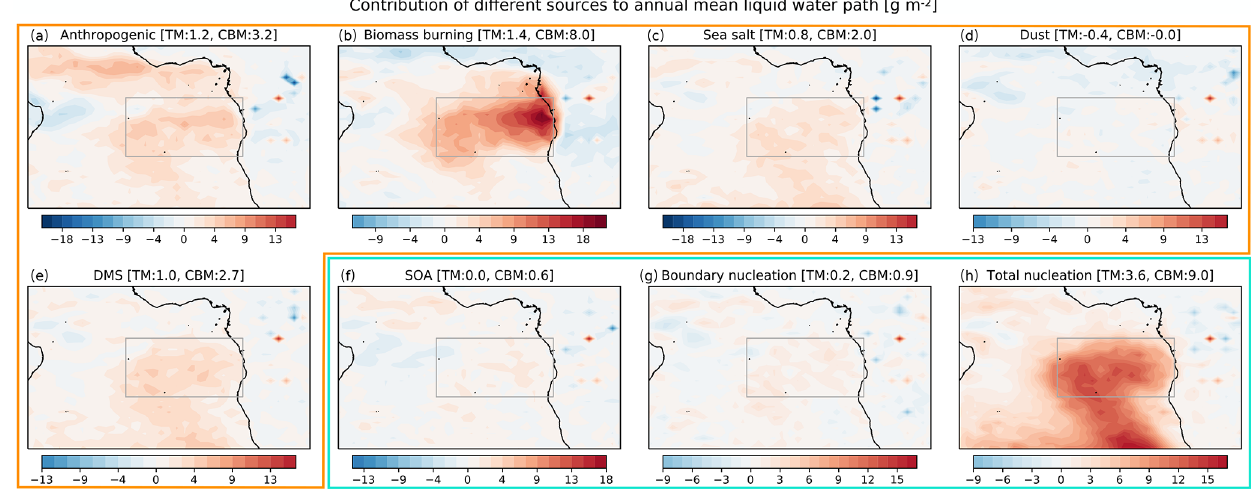
Figure 8. UKESM1-simulated annual mean liquid water path (LWP) from different sources. The contributions of different sources to the LWP are listed in subplots (a) to (h) , where the contribution of emissions is shown using the orange frame, and the contribution of atmospheric processes is shown using the teal frame. The domain in each subplot ranges from 30 ◦ S to 10 ◦ N and from 40 ◦ W to 30 ◦ E. TM is the total mean of the domain, and CBM is the mean of the cloud box (the grey box on the map). The same colour map scale is used in each subplot to facilitate comparison, but the range differs for each plot, corresponding to the maximum and minimum of the LWP.